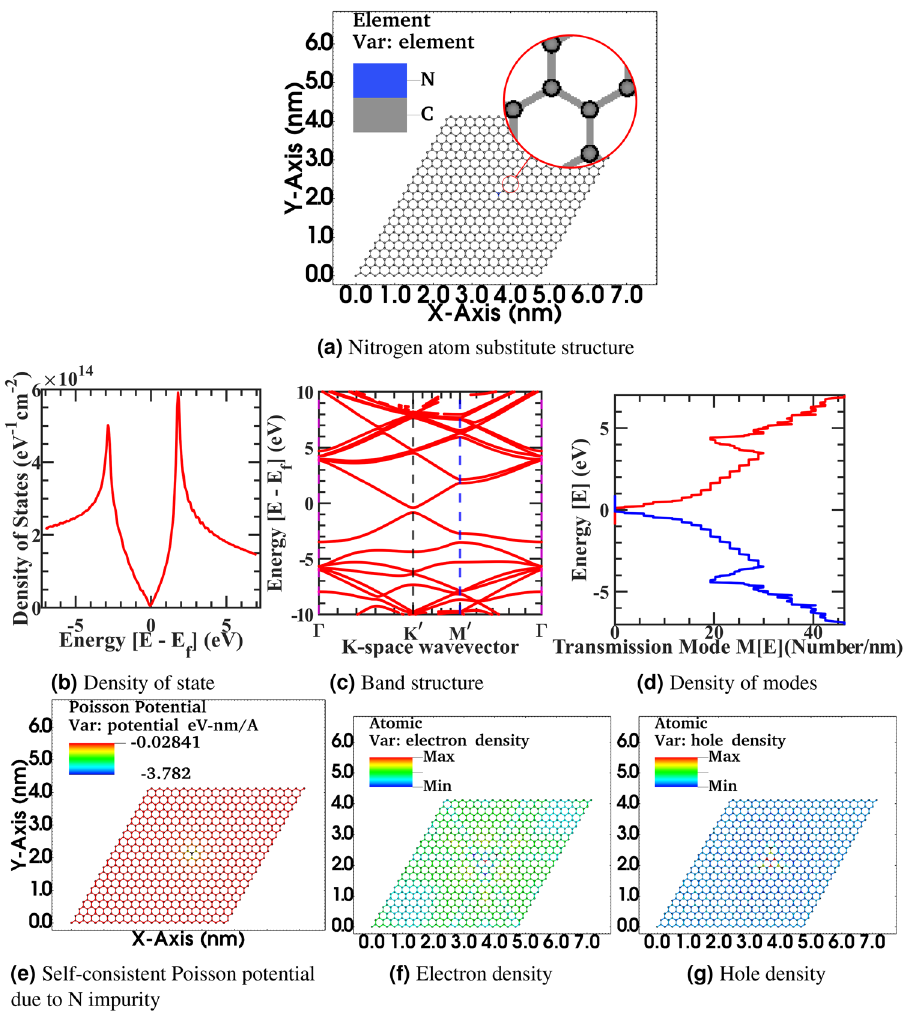
Figure 5. Primitive device structure 20 x 20 graphene supercell with substitutional Nitrogen impurity atom structure ( a ), Density of state ( b ), Electronic band structure ( c ), Density of modes ( d ), Self-consistent Poisson potential due to Nitrogen impurity ( e ), Electronic density ( f ), Hole density ( g